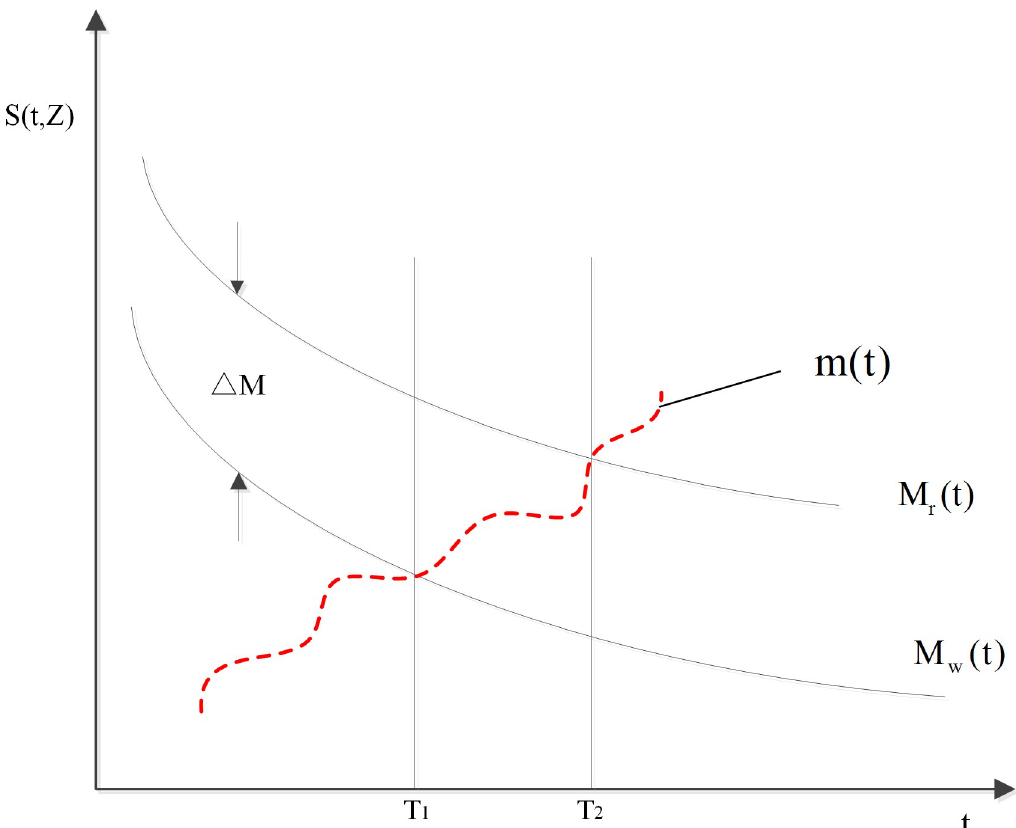
Fig 1. Degradation Event opportunity maintenance